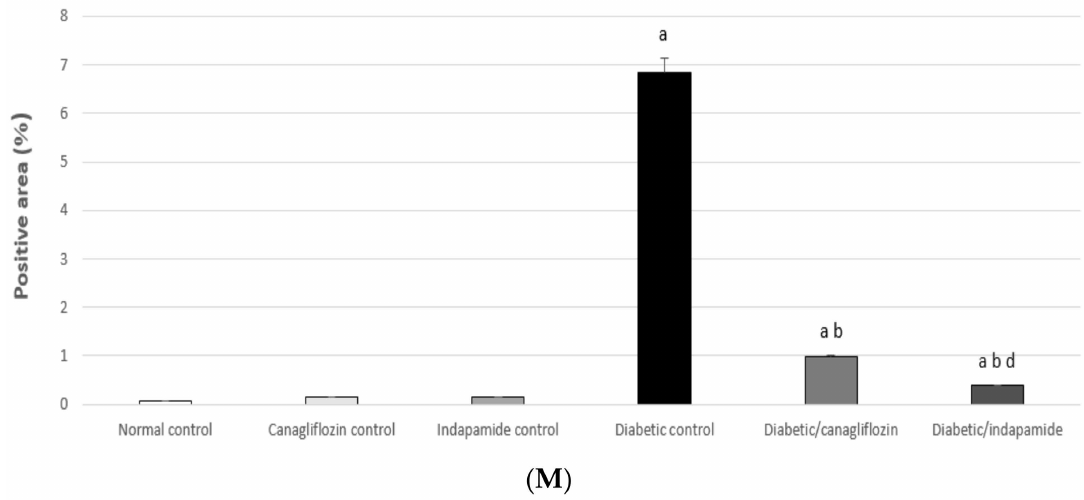
Figure 16. Immunostained epididymal adipose sections against NF- κ B, confirming negative reaction and staining in the normal ( A , B ), CANA ( C , D ), and INDA ( E , F ) CTRLs. Enhanced positive NF- κ B expression in diabetic CTRL (arrows) ( G , H ), and significantly decreased NF- κ B expression in CANA ( I , J ) and INDA ( K , L ) treatment groups. IHC counterstained with Mayer’s hematoxylin. Low magnification: 100 × bar 100; high magnification: 400 × bar 25. ( M ) Impact of daily CANA and INDA treatment on NF- κ B expression in the epididymal adipose tissue: oral CANA and INDA treatments were initiated once daily for 4 weeks. Data represent the mean ± S.E.M. (6 rats/group). ANOVA followed by post hoc Tukey–Kramer test at ( p < 0.05) was used for statistical comparison; a against normal CTRL, b against diabetic CTRL, d against